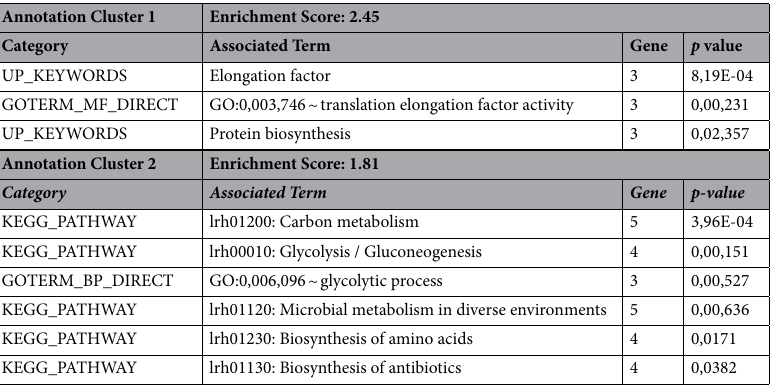
Table 2. GO-functional annotation clusters for L. rhamnosus proteins. The following clusters, resulting from the DAVID-GO Functional Annotation Clustering, represent the secreted proteins of LR06 cultured in TIL.